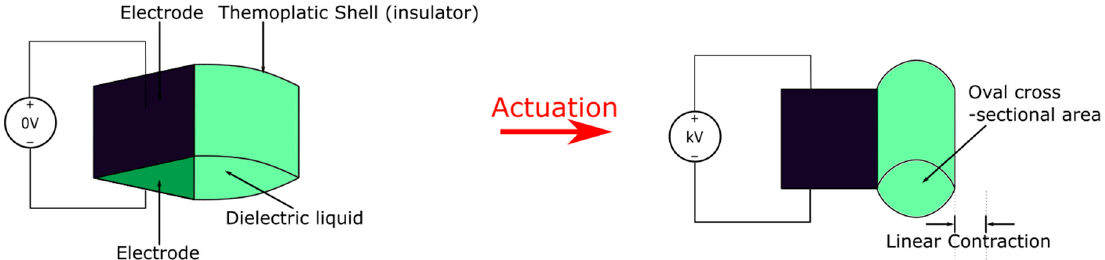
Figure 4. The actuation scheme of a single thermoplastic HASEL pouch. Upon application of a high voltage (kV range), an electrostatic force will form between the two electrodes (black portion) and get further amplified through the dielectric liquid. This force causes the two electrodes to pull together and squeeze the liquid out of the region covered by the electrodes. This will cause the uncovered pouch to form an oval-shaped cross-sectional area and the shape-change ultimately creates a linear contraction in the length direction.